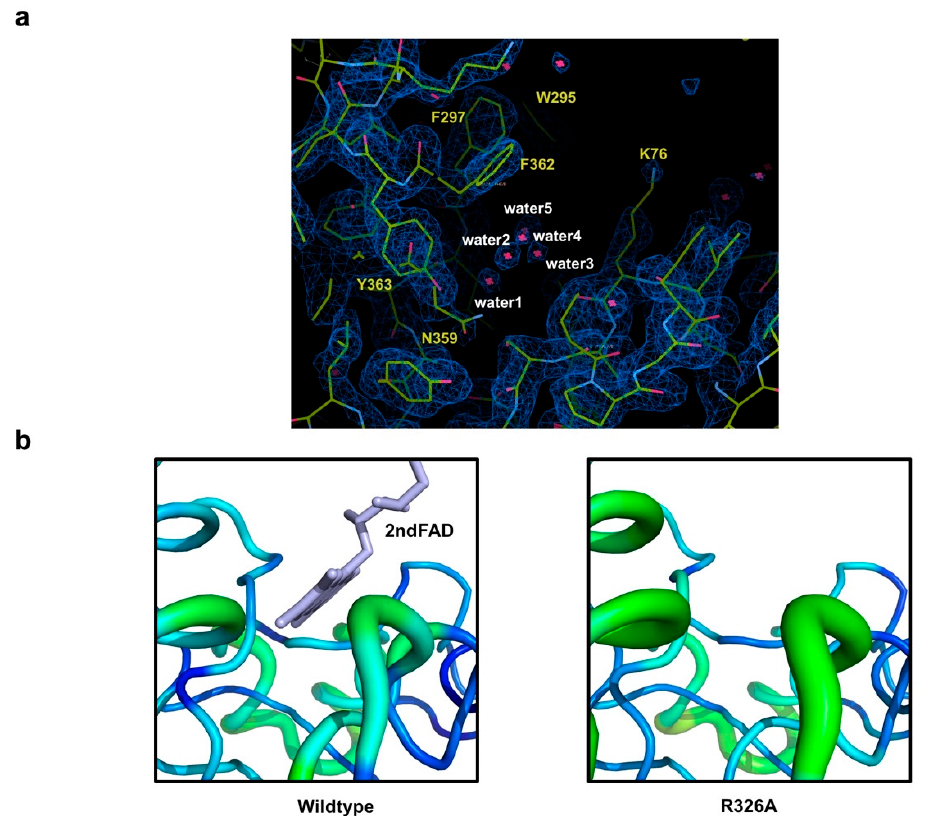
Figure 4. Analysis of the feature of the 2nd FAD binding site in Osm1 R326A: ( a ) An omit density map contoured at the 1- σ level around the 2nd FAD binding site in Osm1 R326A; red star marks indicate water molecules; five waters in the 2nd FAD binding cavity are numbered; ( b ) B-factor distribution of the 2nd FAD binding site; the structure is presented in a putty representation and rainbow-colored from red to violet in B-factor value order.